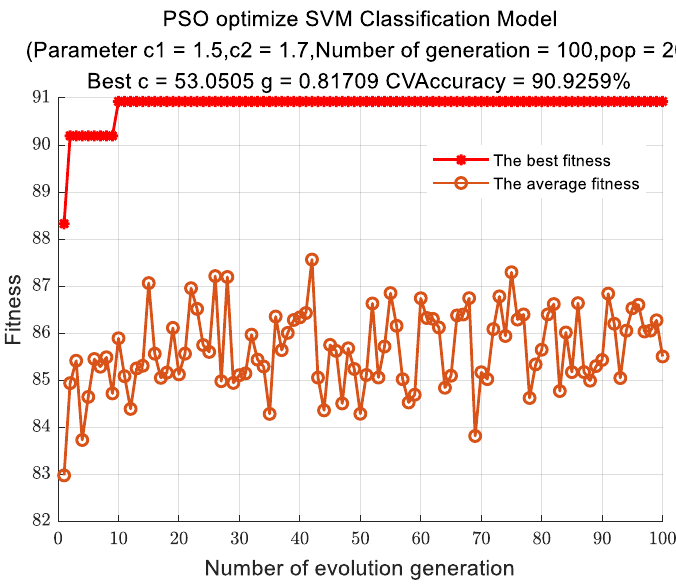
Figure 13. PSO optimization process of SVM parameters.